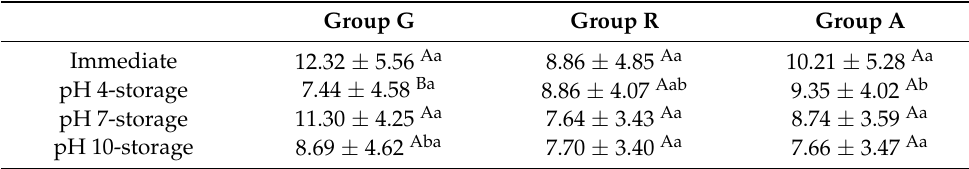
Figure 2. ( A ) Micro-tensile bond strength of the experimental groups. Same lower letters on top of the bar denote no statistical differences between groups ( p > 0.05). Long bar means no significant differences among groups. ( B ) Distribution of failure modes. Table 2. Micro-tensile bond strength